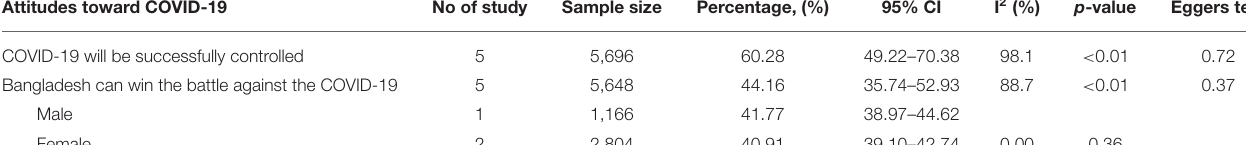
TABLE 3 | Pooled prevalence of attitude toward COVID-19 among Bangladeshi residents. Attitudes toward COVID-19